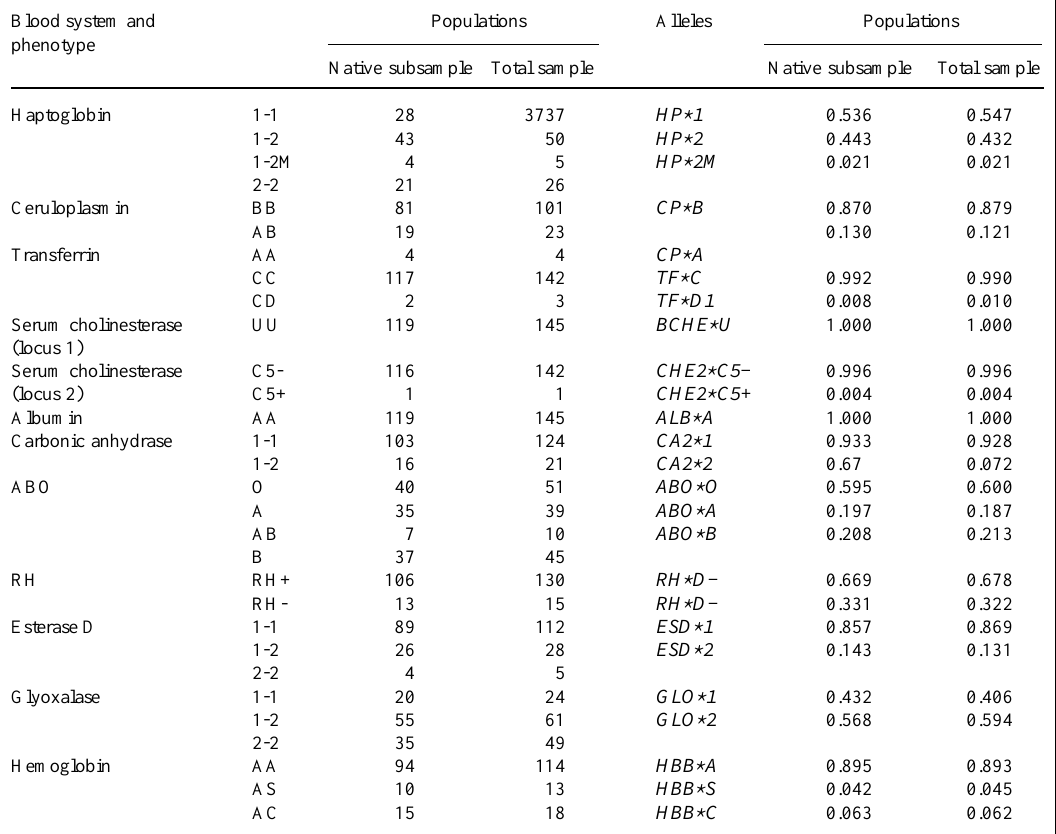
Table II - Observed phenotype and allele frequencies in Curiau and its native subsample 1 .